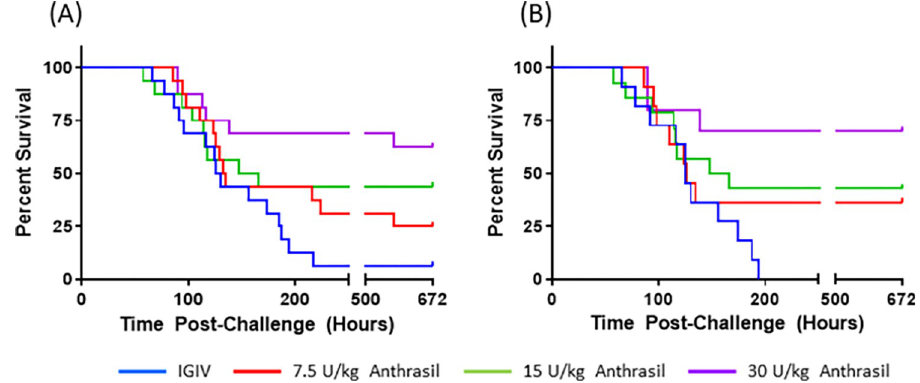
Fig 3. Kaplan-Meier curves representing time-to-death and survival data in B . anthracis -infected nonhuman primates treated with IGIV or ANTHRASIL. Kaplan-Meier curves for survival and time to death in nonhuman primates. Bacillus anthracis spore- challenged cynomolgus macaques were treated with IGIV or three different doses of ANTHRASIL upon detection of toxemia. A) Intent to treat group- all animals that received the treatment B) Modified intent to treat- only animals that were bacteremic at least once prior to treatment were included.